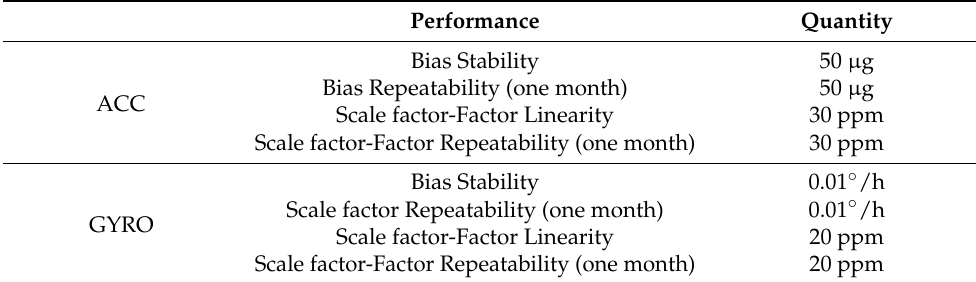
Table 5. Performance of the tested INS.